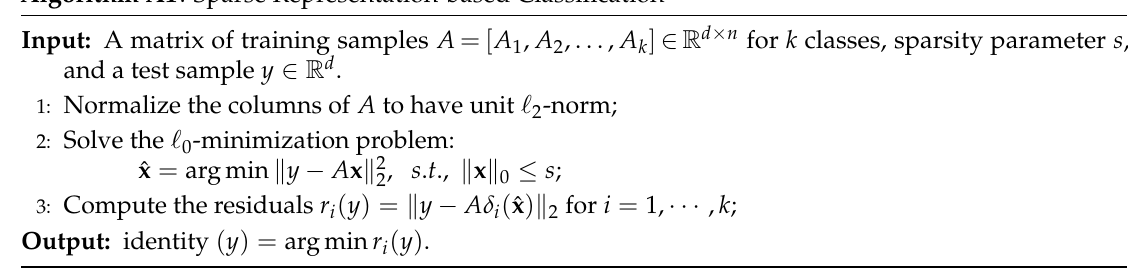
Algorithm A1 : Sparse Representation-based